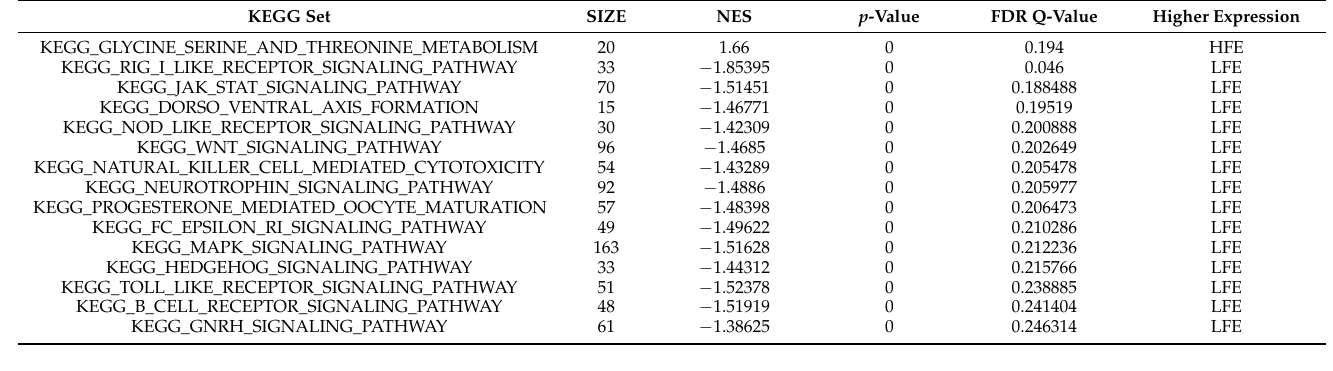
Table 6. List of all gene sets with an FDR ≤ 0.25.